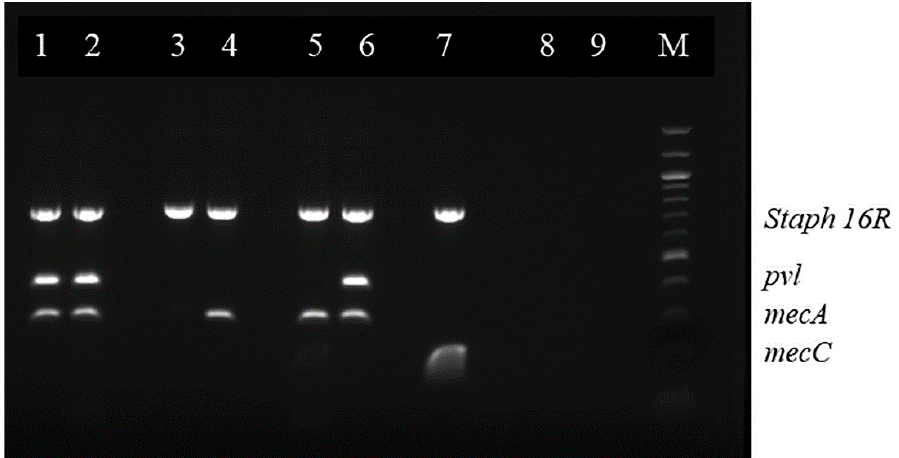
Figure 2. Multiplex PCR for coagulase positive staphylococci. M — Promega ® 100 BP DNA Ladder; Lanes 1 – 5 tested isolates; 6, MRSA (ATCC 1756) positive control for Staph 16R , pvl and mecA ; 7, MRSA (ATCC 2312) positive control for Staph 16R and mecC ; 8 – 9 negative controls.